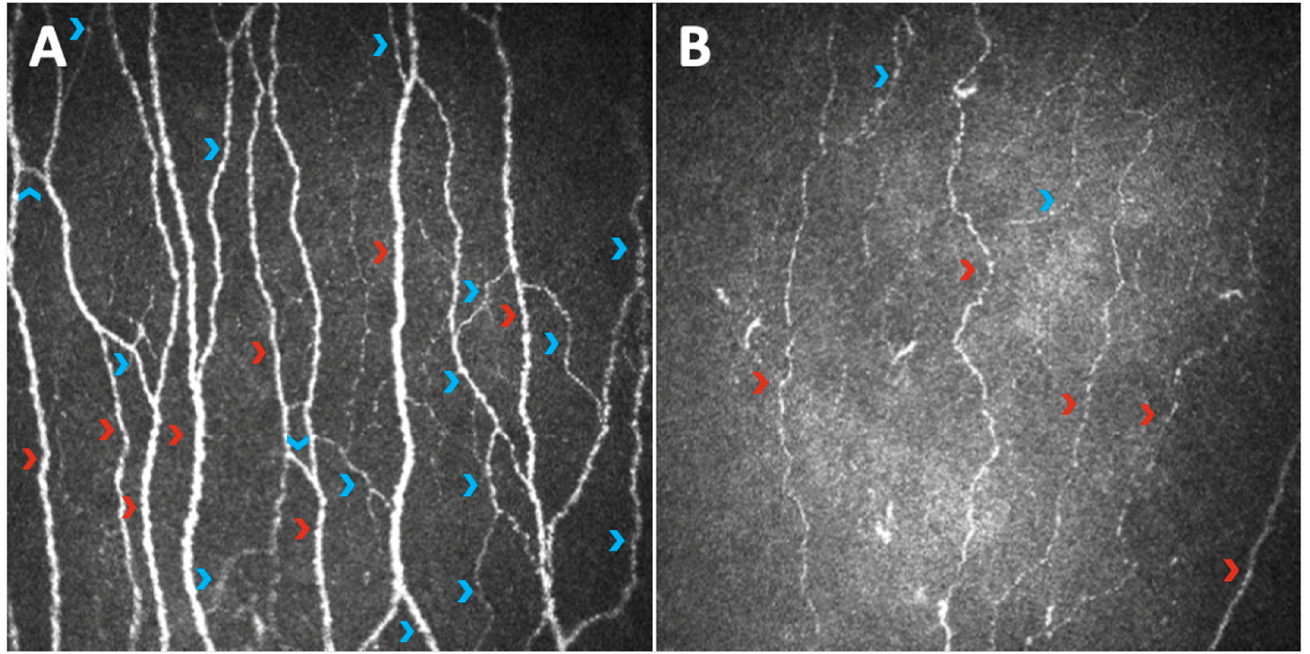
Figure 1. Images of the sub-basal nerve plexus captured with Heidelberg Retina Tomograph III Rostock Corneal Module (Heidelberg, Germany) from the central cornea of a healthy subject ( A ) and a diabetic subject with diabetic peripheral neuropathy ( B ). The comparison clearly shows the paucity of corneal nerve fibers in the diabetic neuropathic patient; in particular, there is evidence of a reduction in both the main fibers (red arrowheads) and the branches (blue arrowheads), determining a decrease in corneal parameters of length and density such as CNFL, CNFD, and CNBD.